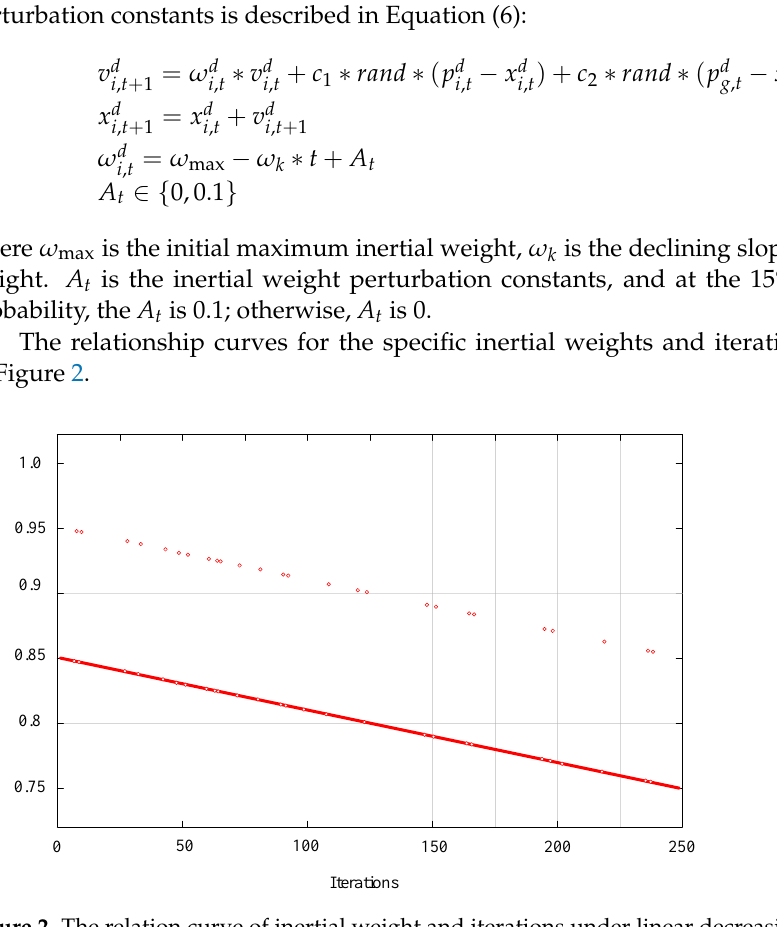
4 of 13 Figure 1. The relation curve of inertial weight and iterations under linear decreasing. Linearly decreasing the inertial weight can significantly improve the optimization performance of the particle swarm optimization. However, the particle swarm optimiza- tion under a linearly decreasing inertial weight easily falls into the local convergence. Therefore, in the implementation of the particle swarm optimization, a certain amount of